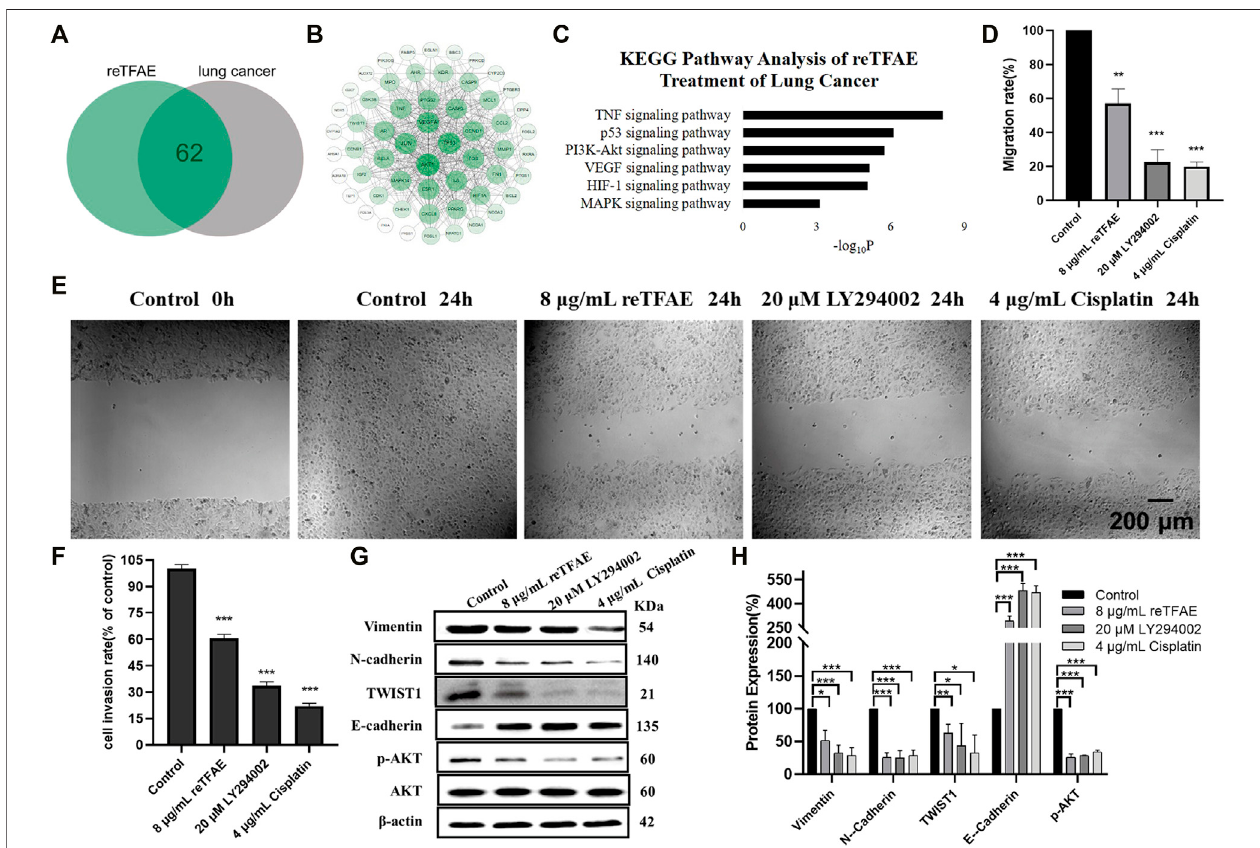
FIGURE 2 | reTFAE inhibited the PI3K/Akt pathway to inhibit EMT processes of A549 cells. (A) Intersection protein targets of reTFAE and lung cancer. reTFAE targets and lung cancer targets shared 62 proteins. (B) Protein – protein interaction (PPI) network of 62 proteins. AKT1, TP53, VEGFA, and JUN showed more connections with other proteins. (C) KEGG pathway analysis of 62 proteins. p < 0.01 was the cutoff for displaying the pathways. (D,E) Both reTFAE and PI3K/AKT pathway inhibitors inhibited the migration of A549 cells ( n = 3). (F) Both reTFAE and PI3K/AKT pathway inhibitors inhibited the invasion of A549 cells ( n = 3). (G,H) The in fl uence of PI3K/Akt-suppression and reTFAE on the expression of EMT-related proteins ( n = 3). Statistical differences were determined by a two-sided Student ’ s t -test. Compared with control, N.S. not signi fi cant, *** p < 0.001; ** p < 0.01; * p < 0.05.